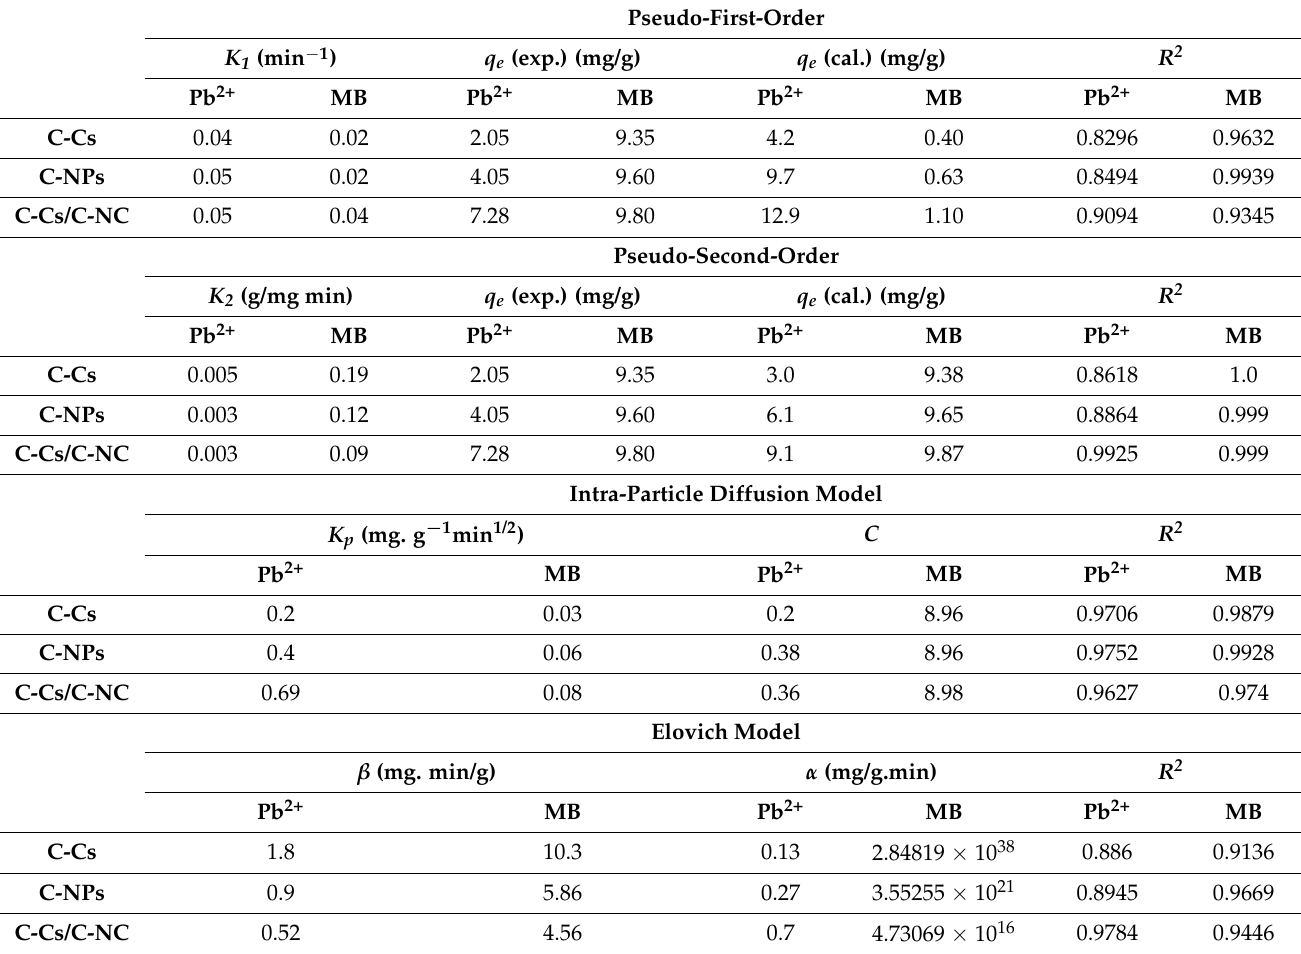
Table 2. Parameters of kinetics for Pb 2+ and MB removal onto C-Cs, C-NPs, and C-Cs/C-NC.